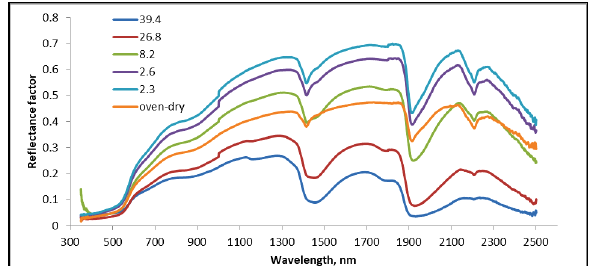
Figure 3 Reflectance spectra of red soil against wavelength for various percentage of moisture